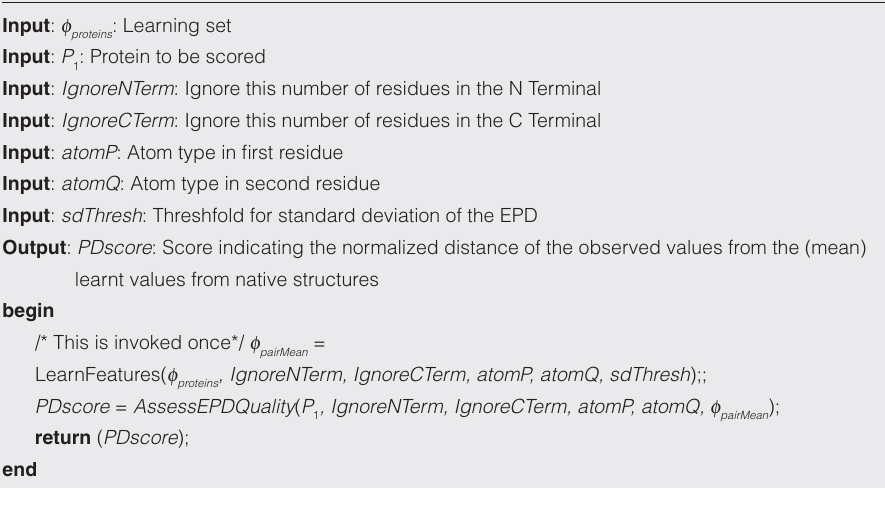
Algorithm 3. ESCAPIST(): Top level